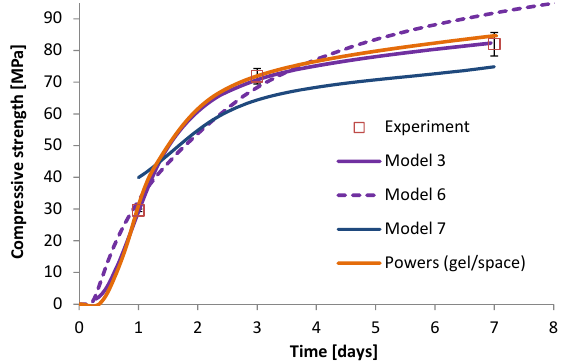
Figure 4. Comparison of the experimental data and simulation results for compressive